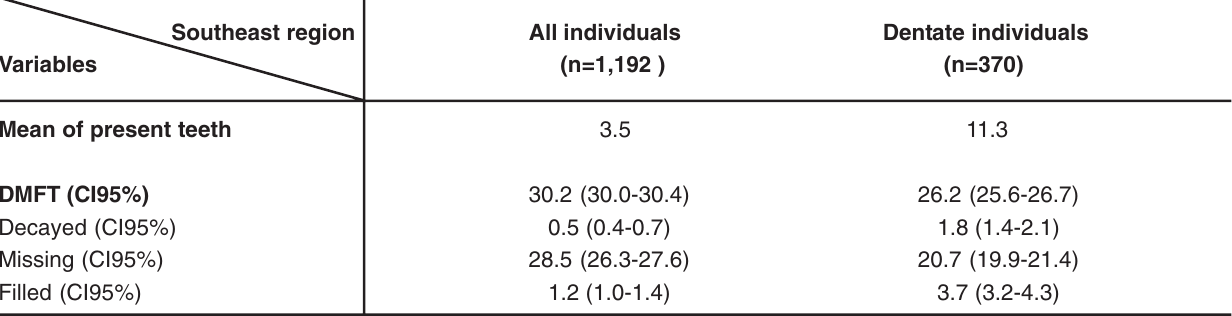
TABLE 2- Mean of present teeth and caries experience in all individuals and among dentate individuals. Southern Region of the state of São Paulo